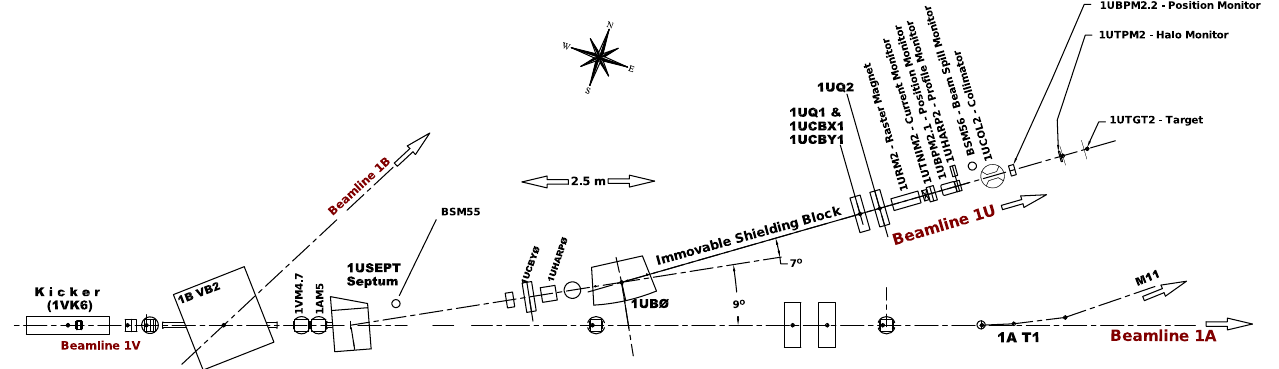
FIG. 2. A schematic top view of the proton beamline for the UCN facility at TRIUMF (see also [5]). Beam from the TRIUMF cyclotron enters through beamline 1V from the left side of the figure and proceeds to the right. The proton beam is diverted, as required, into beamline 1U by the kicker and septum magnets. Downstream of the septum, beamline 1U contains bender magnets, quadrupole magnets, and diagnostic elements before ending in the target. The principal elements relevant to the kicker magnet design are discussed further in the text.